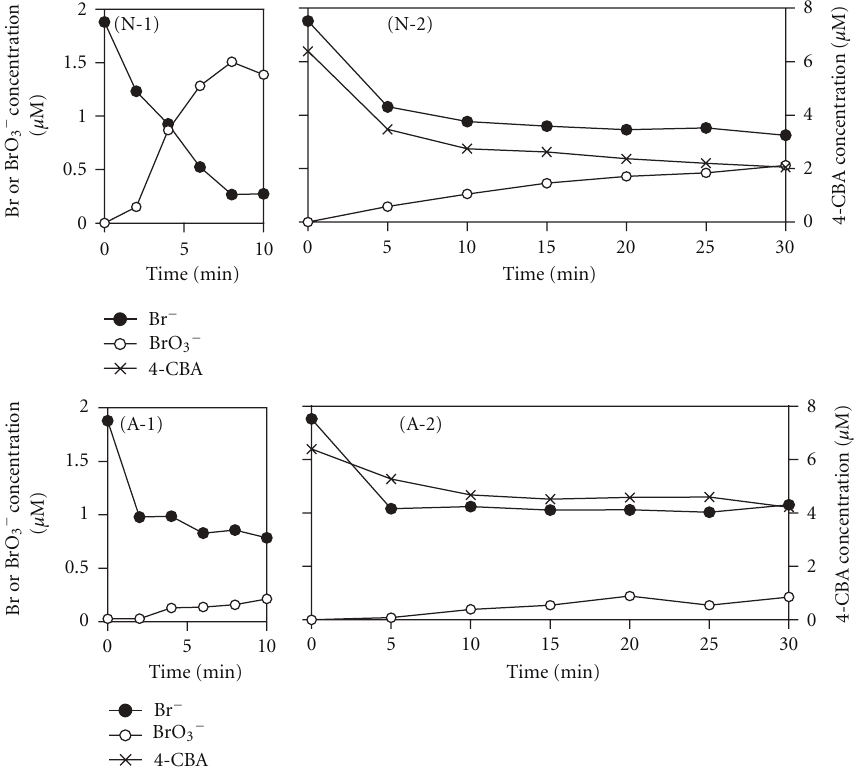
Figure 4: Changes in concentrations of Br − , BrO 3 − , and 4-CBA during ozonation at neutral pH without 4-CBA (N-1), ozonation at neutral pH with 4-CBA (N-2), ozonation at acidic pH without 4-CBA (A-1), and ozonation at acidic pH with 4-CBA